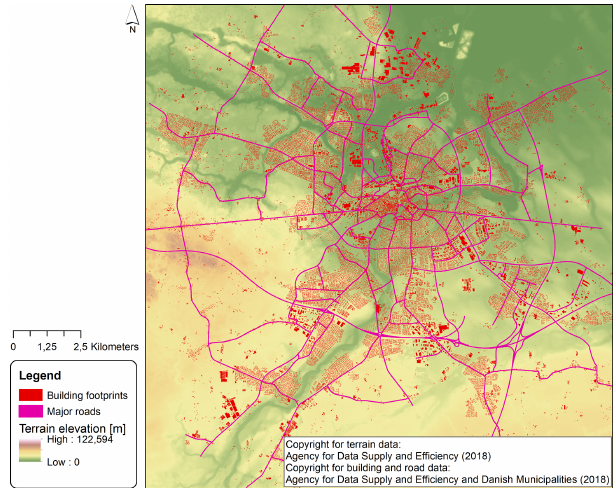
Figure 1. Terrain elevations in Odense, footprints of buildings exist- ing in 2017 and major road network. See © Agency for Data Supply and Efficiency (2018) and © Agency for Data Supply and Efficiency and Danish Municipalities (2018) for copyright conditions relating to building, terrain and road